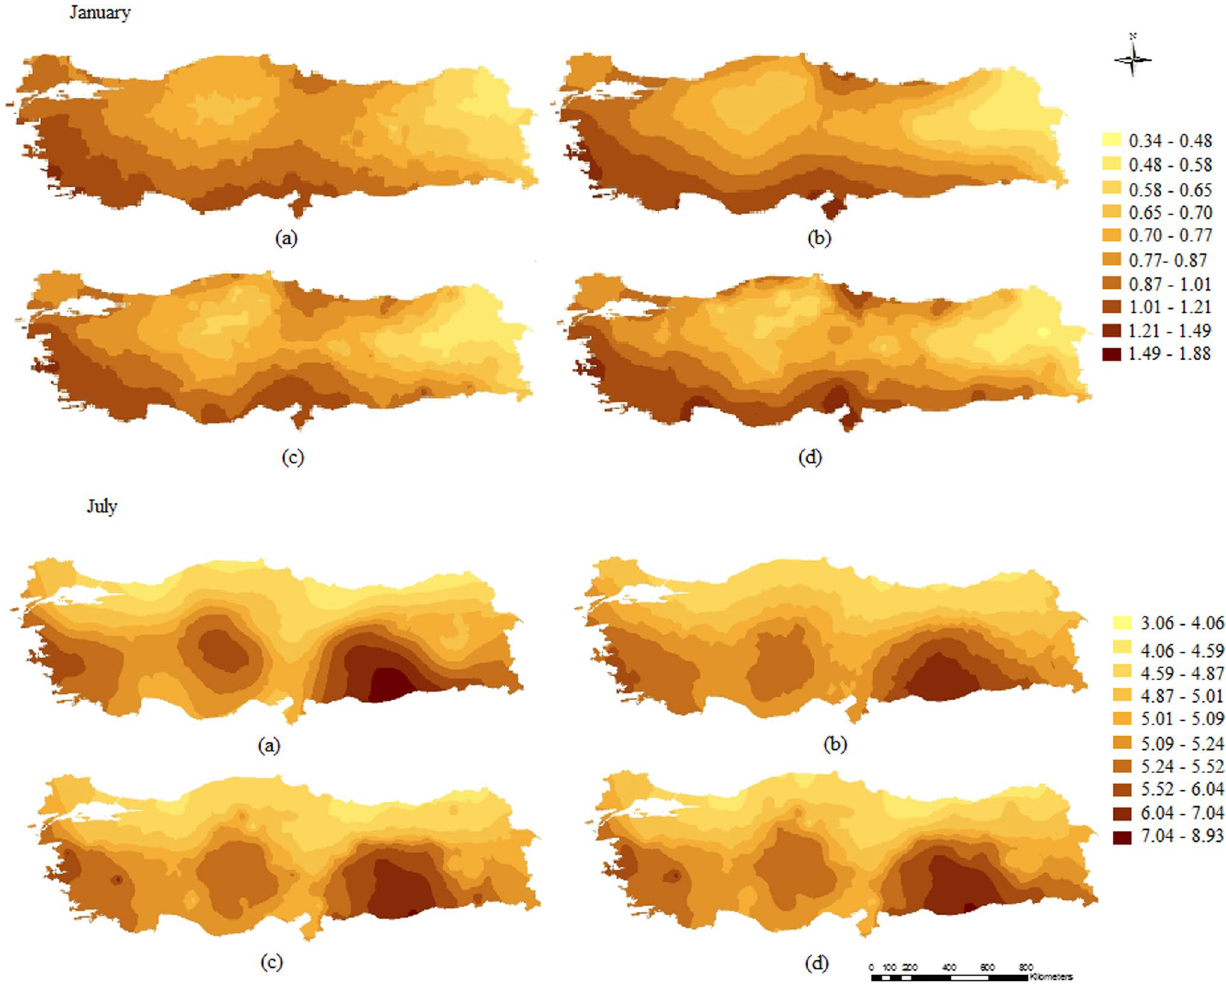
Fig. 6 Spatial distribution maps for ET 0 predicted for June and July interpolated by a OK b COK c IDW, and d